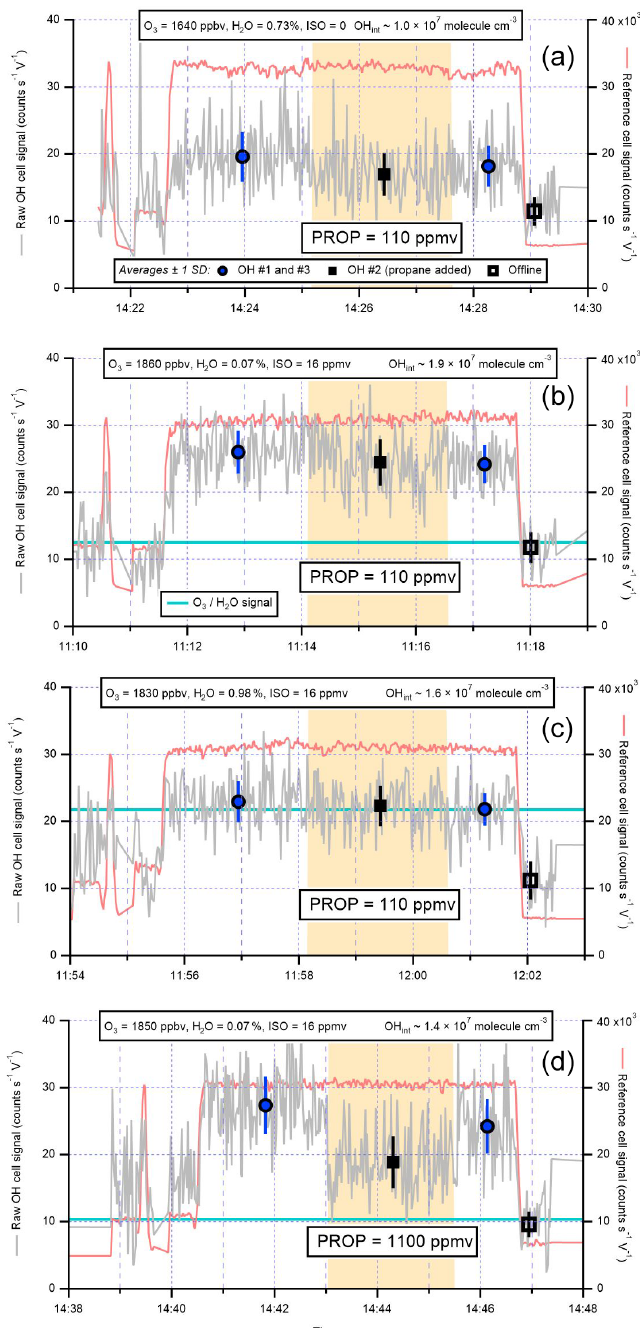
Figure 8. Isoprene (ISO) ozonolysis interference tests: (a) O 3 / H 2 O only, (b) O 3 and ISO under dry conditions, (c) O 3 and isoprene with H 2 O added, and (d) O 3 and isoprene under dry conditions but with a higher concentration of propane (PROP) to remove any steady-state- generated OH. Shaded areas are periods of propane addition, and the light blue lines correspond to the calculated signals from O 3 + H 2 O only (for experiments with isoprene present). The interference signals (“OH no. 2” – “offline”) were used to derive equivalent OH concentrations (OH int ), which are on the order of ∼ 1–2 × 10 7 molec.cm − 3 . These experiments are summarised in Table 3. See text for further